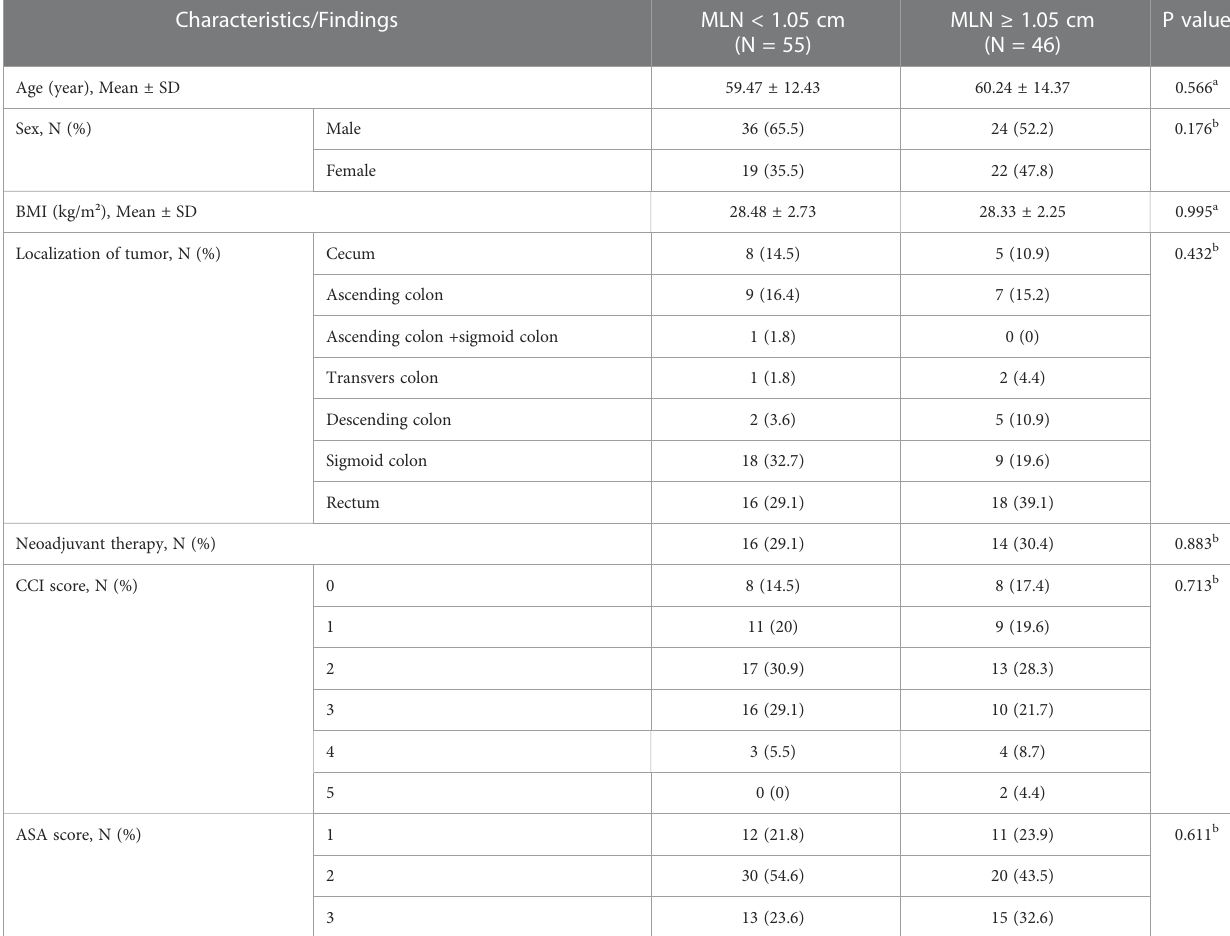
TABLE 5 Comparison of patient characteristics according to the diameter of largest MLN.